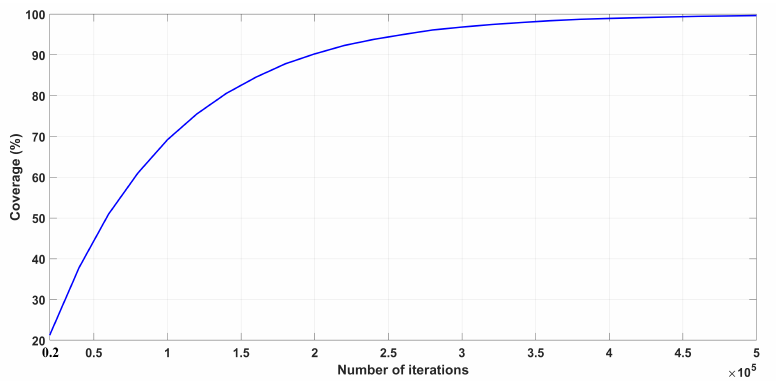
Figure 15. Coverage stats with respect to number of